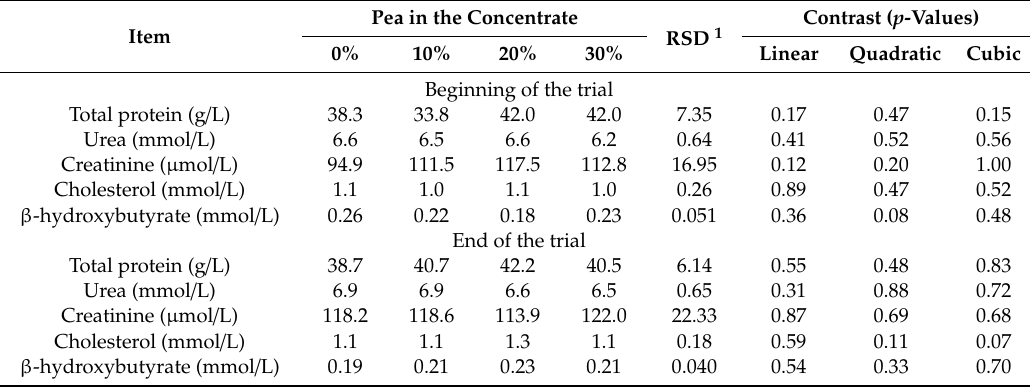
Table 4. E ff ect of inclusion of field pea in the concentrate on plasma metabolites at the beginning and end of the in vivo digestibility trial.